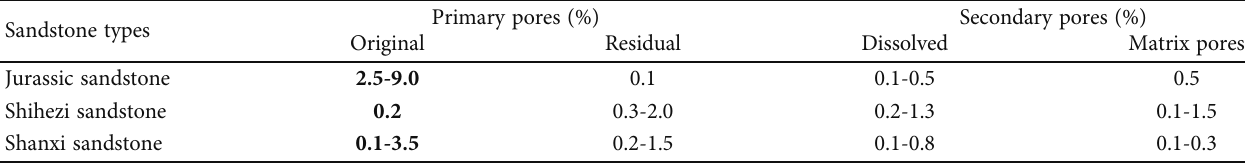
Table 3: Types and contents of intergranular pores in deep mine sandstone ∗